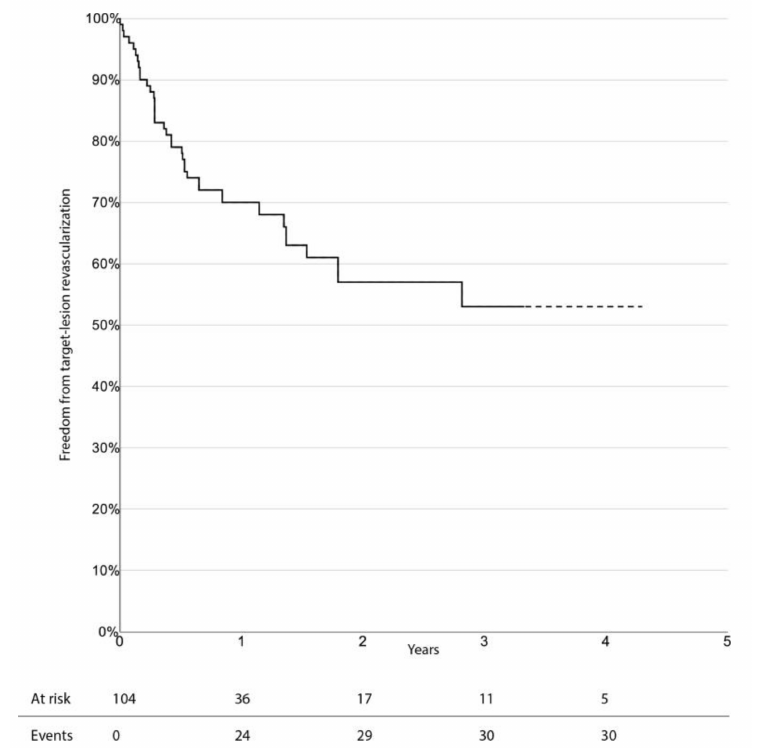
Figure 2. Survival estimate for freedom from target-lesion revascularization.